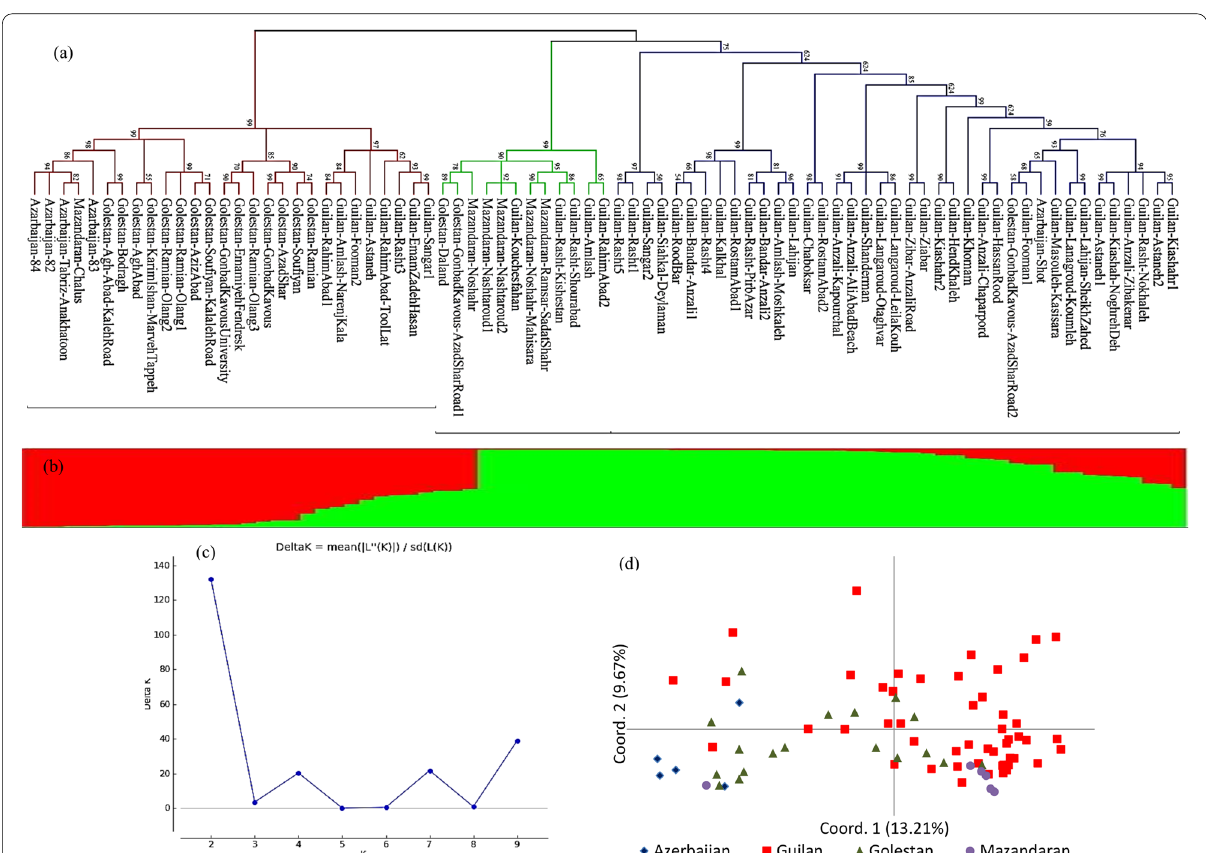
Fig. 2 The genetic relationships and population structure of the 79 Ae. tauschii accessions based on IRAP data concluded from a distance and model-based cluster analyses and PCoA. a Neighbor-joining phylogenetic tree, b population structure on K versus Δ K for determining ideal K -value, and d PCoA based on the first two